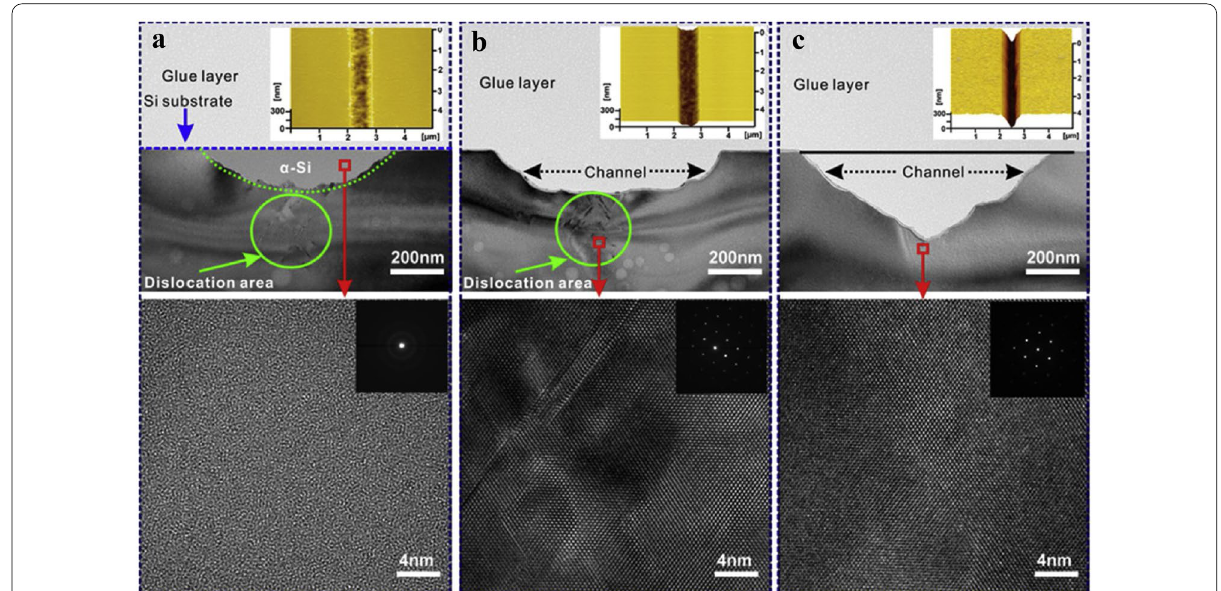
Figure 14 HTEM detection on cross section of scratched regions before and after being etched by HF and HF/HNO 3 mixture